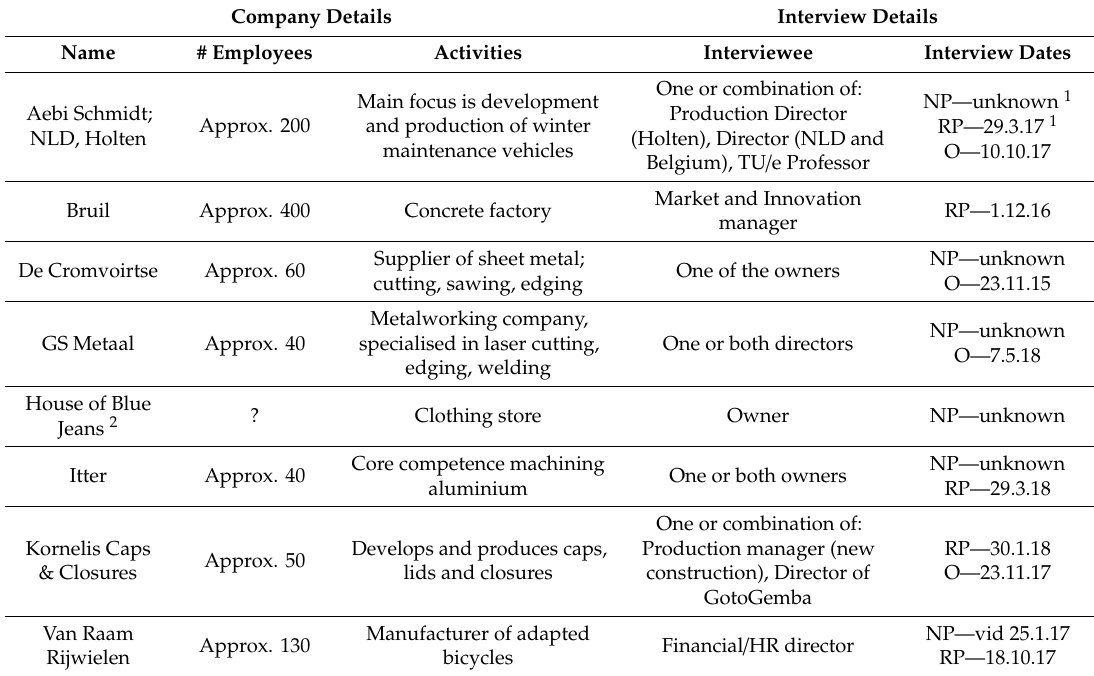
Table 2. Company and interview details for each